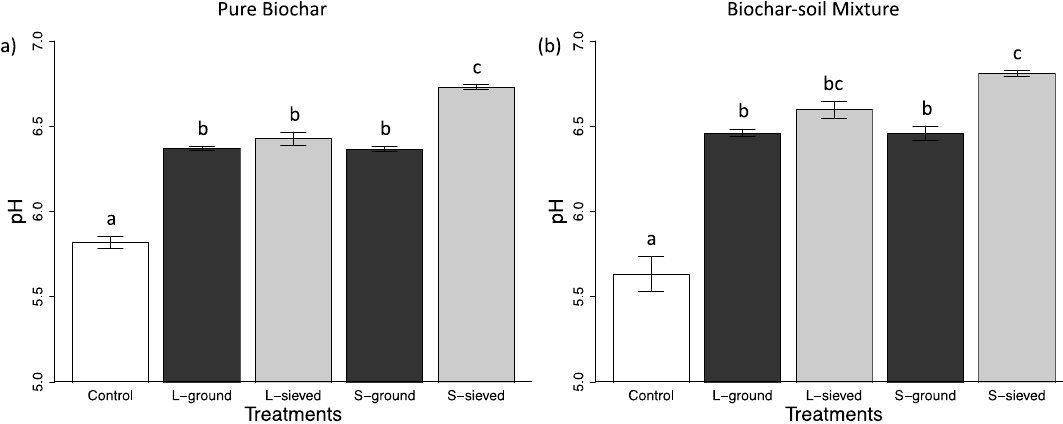
Figure 4. pH of pure biochar and control (sand) ( a ) and pH of the biochar-soil mixture and control ( b ). Means are plotted ± 1 standard error (SE) based on triplicate measurements within each treatment. Within each panel, bars with the same lower case letters do not differ significantly at p < 0.05 according to Tukey’s HSD test.